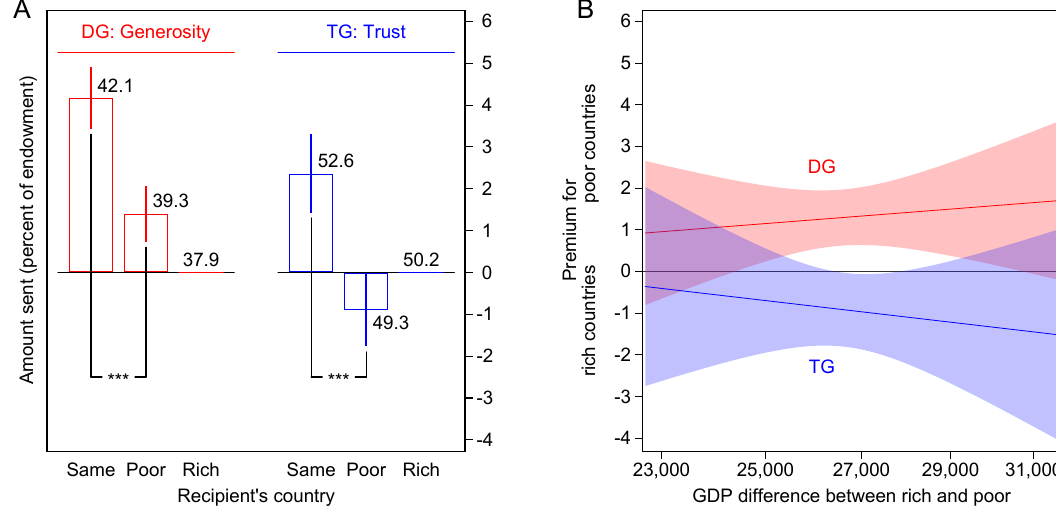
Figure 1: ( A ) Average rates of cooperation (mean transfers as a percentage of the endowment) reveal significant in-group favoritism, a generosity effect toward poor-country counterparts, and a trust effect toward rich- country counterparts. We report paired two-sided t tests (and 95% confidence intervals) that contrast elicited behavior with the mean transfers to counterparts from rich countries (*** indicates differences significant at the level p < 0.001). ( B ) The opposing status effects increase with perceived material neediness difference. We plot the predicted difference in mean transfers to poor minus rich countries in the dictator game (DG; red) and the trust game (TG; blue) against the difference between the (logged) average gross domestic product (GDP) per capita in current international PPP$ of rich and of poor countries (95% confidence intervals based on robust standard errors). The status effects from panel A are greater when GDP differences are